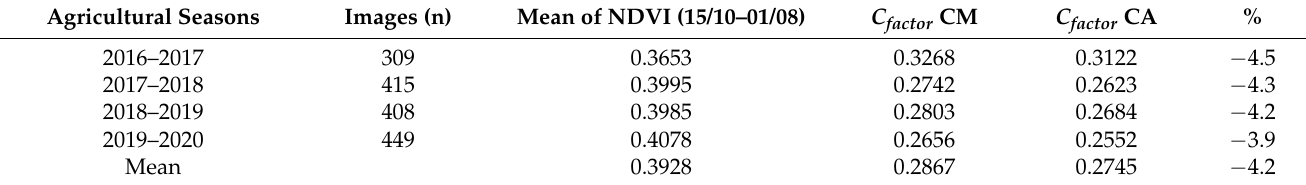
Table 1. C -factor and NDVI values of ACL of the four cycles and two management systems. Agricultural